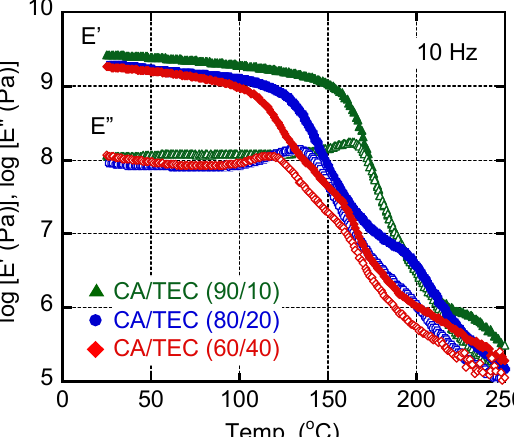
Figure 2. Temperature dependencies of the tensile storage modulus E ’ (filled symbols) and loss modulus E ” (closed symbols) at 10 Hz of CA films with various amounts of TEC: 10 wt% (triangles), 20 wt% (circles), and 40 wt% (diamonds).